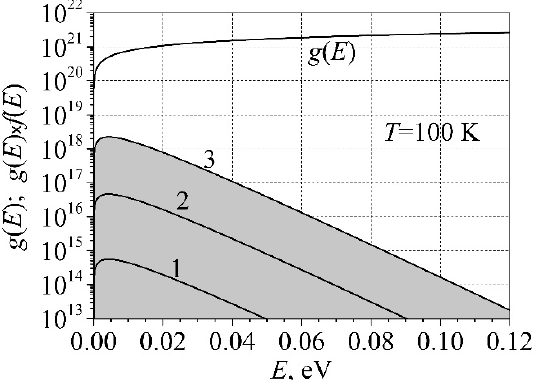
Figure 4. The conduction band state filling function g ( E ) f ( E ) dependence on energy for three phos- phorous doping densities, in cm − 3 :1—10 13 ; 2—10 15 ; 3—10 17 . The densities of electrons below the curves are equal to the ionized phosphorous donor densities.